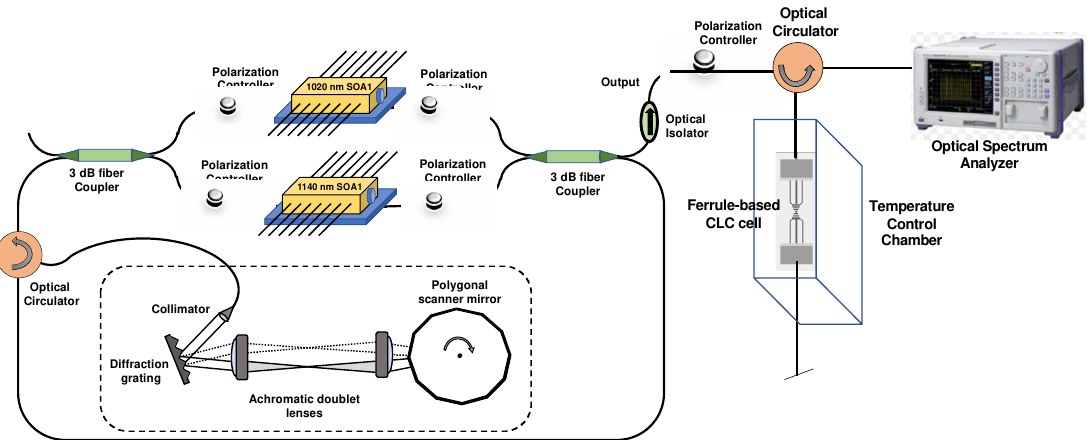
Figure 4. Experimental setup of the temperature sensor using wideband WSL.